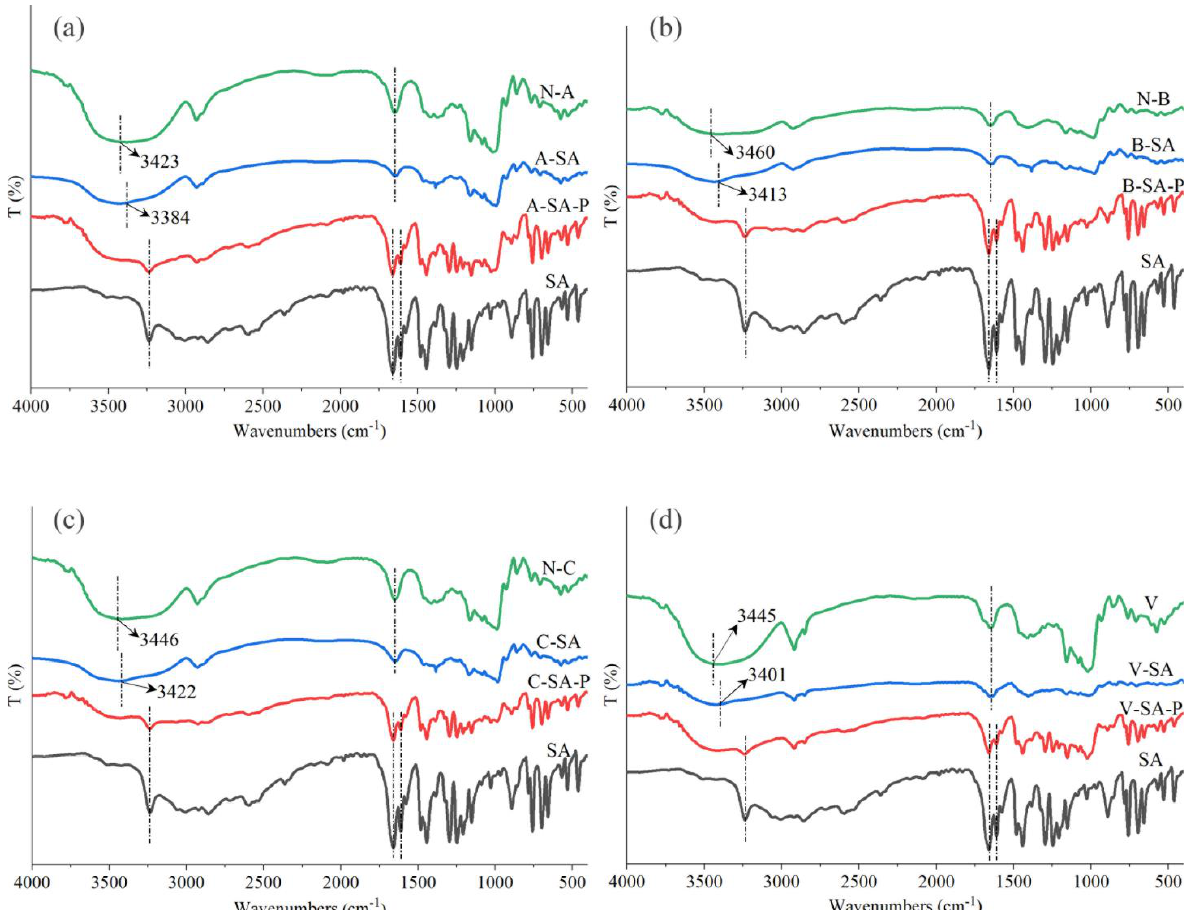
Figure 3. FTIR spectra of ( a ) N–A, A–SA, A–SA–P, and SA; ( b ) N–B, B–SA, B–SA–P, and SA; ( c )